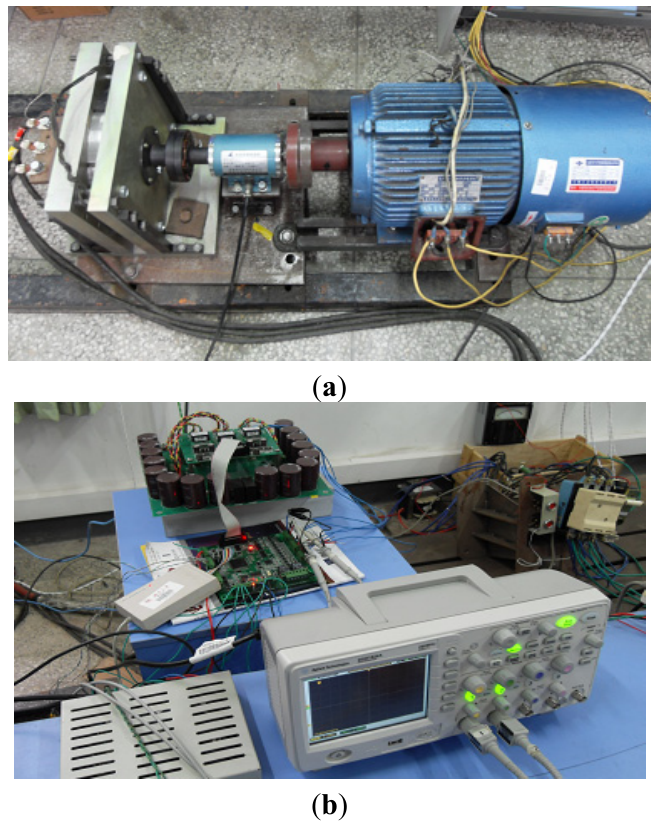
Figure 11. System configuration for the experimental. ( a ) Drive control platform; and ( b ) motor testing